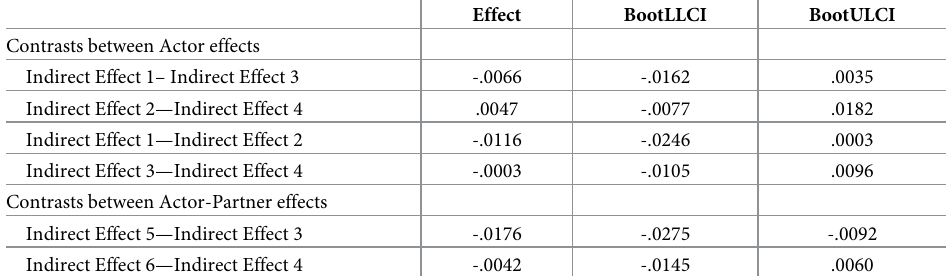
Table 3. The contrasts between significant indirect actor effects and between indirect actor-partner